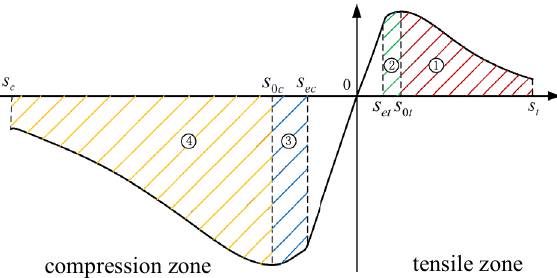
Figure 7. Damage constitutive force function curve of brittle